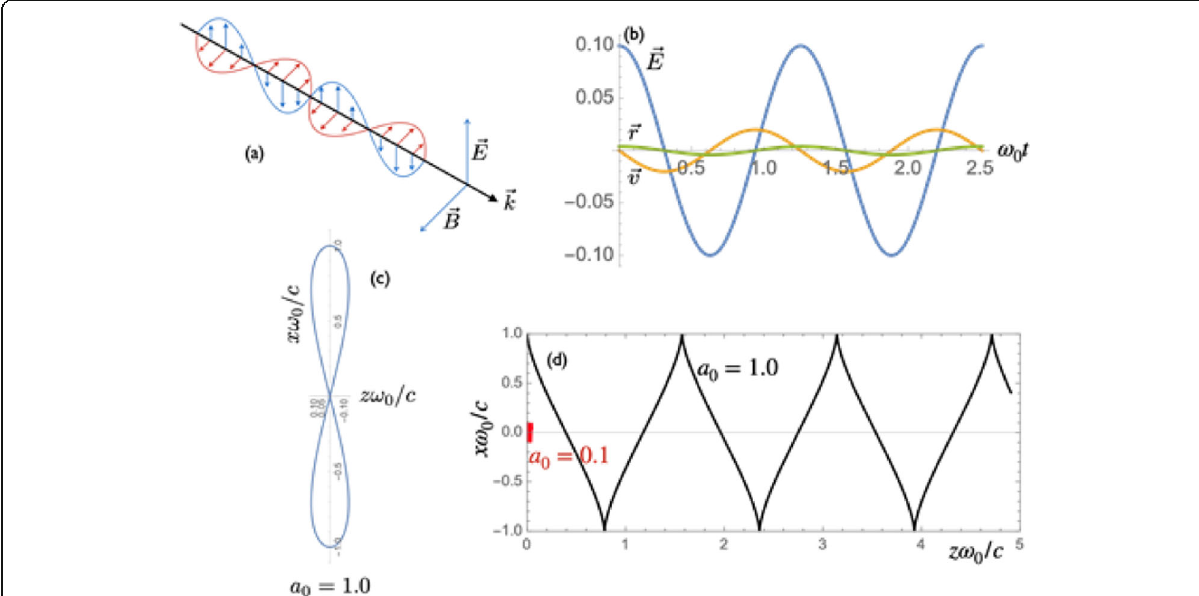
Fig. 8 Single particle motion in a plane electromagnetic wave: a electromagnetic field of a laser and b profiles of the electric field (blue), electron velocity (yellow), and electron transverse position (green) with respect to ω 0 t , c electron trajectory in the frame of reference moving with the electron longitudinal drift, and d electron motion in space for non-relativistic ( a 0 = 0.1) and relativistic ( a 0 = 1.0) cases